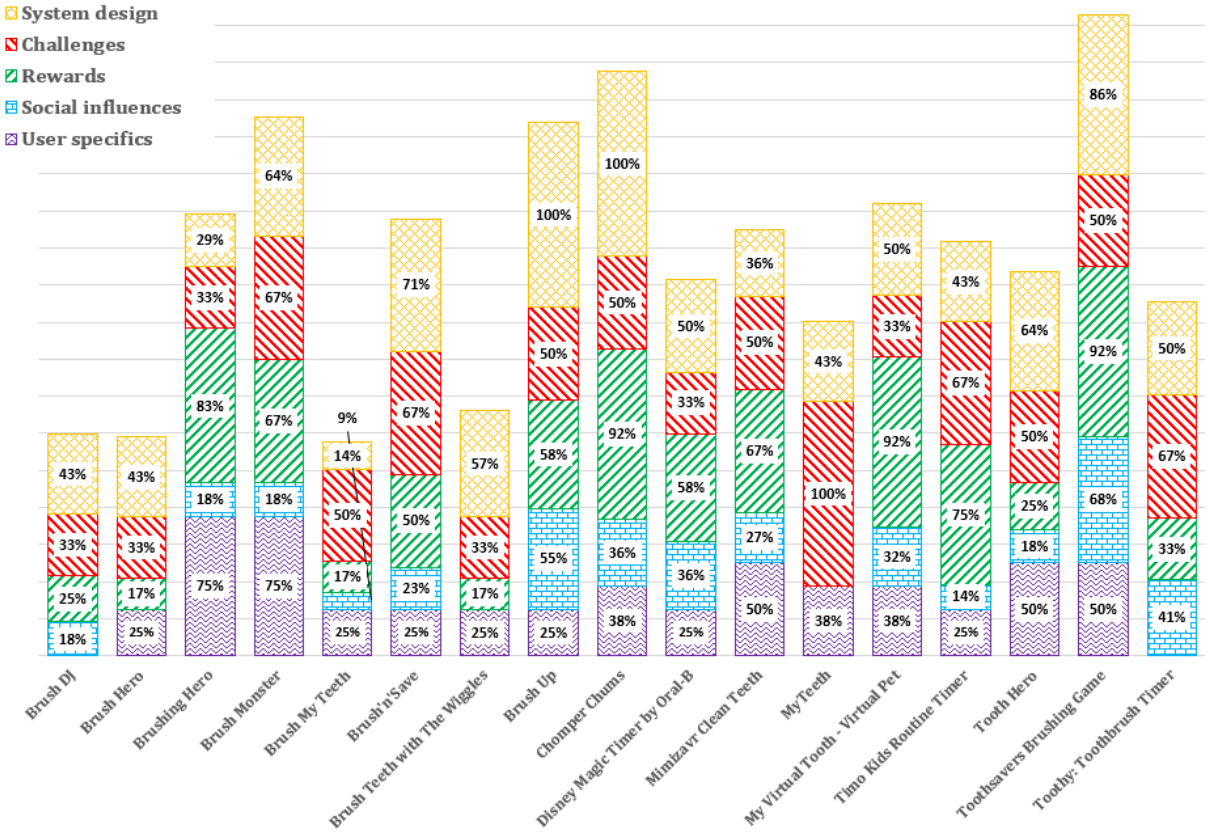
Figure 3. Percentage of gamification component categories for each